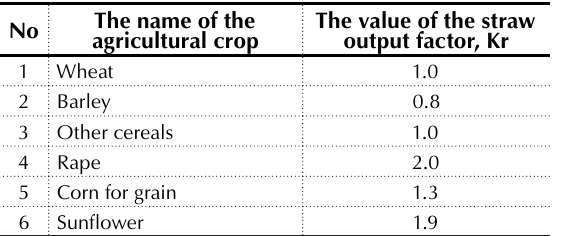
Table 2. The value of the straw output coefficient for cereals